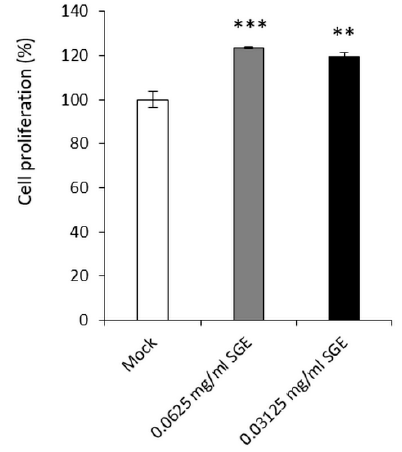
Figure 5. SGE stimulated the cell proliferation of human primary epidermal keratinocytes. Cells were treated with 0.03125, 0.0625 mg/ml of SGE, or left untreated as a control (Mock, white bar, 100%). Both 0.03125 mg/ml (grey bar) and 0.0625 mg/ml (black bar) of SGE were able to enhance cell viability after a 24-hour treatment. **, P < 0.01 versus Mock; ***, P < 0.001 versus Mock. SGE, Sargassum glaucescens extracts.